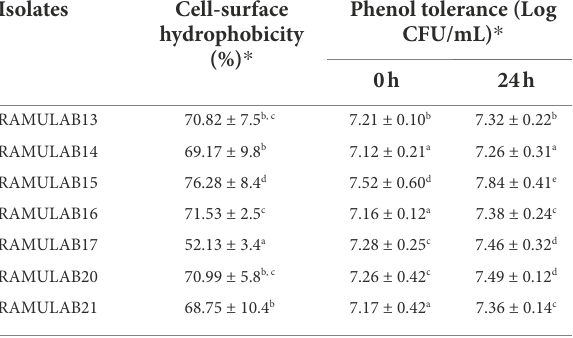
TABLE 2 Cell surface hydrophobicity (%) and phenol tolerance (Log CFU/mL) of the isolates.